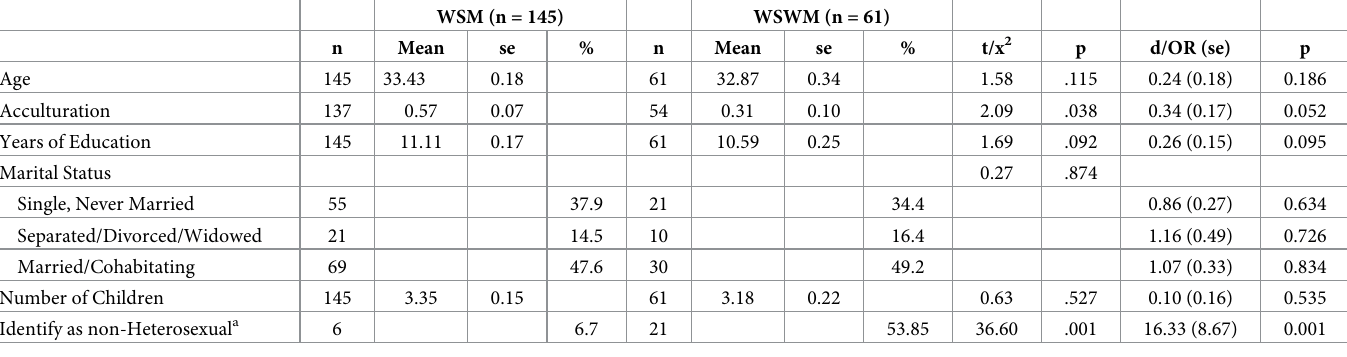
Table 1. Differences in individual-level factors between Women who have Sex with Men (WSM) and Women who have Sex with Women and Men (WSWM) in proyecto